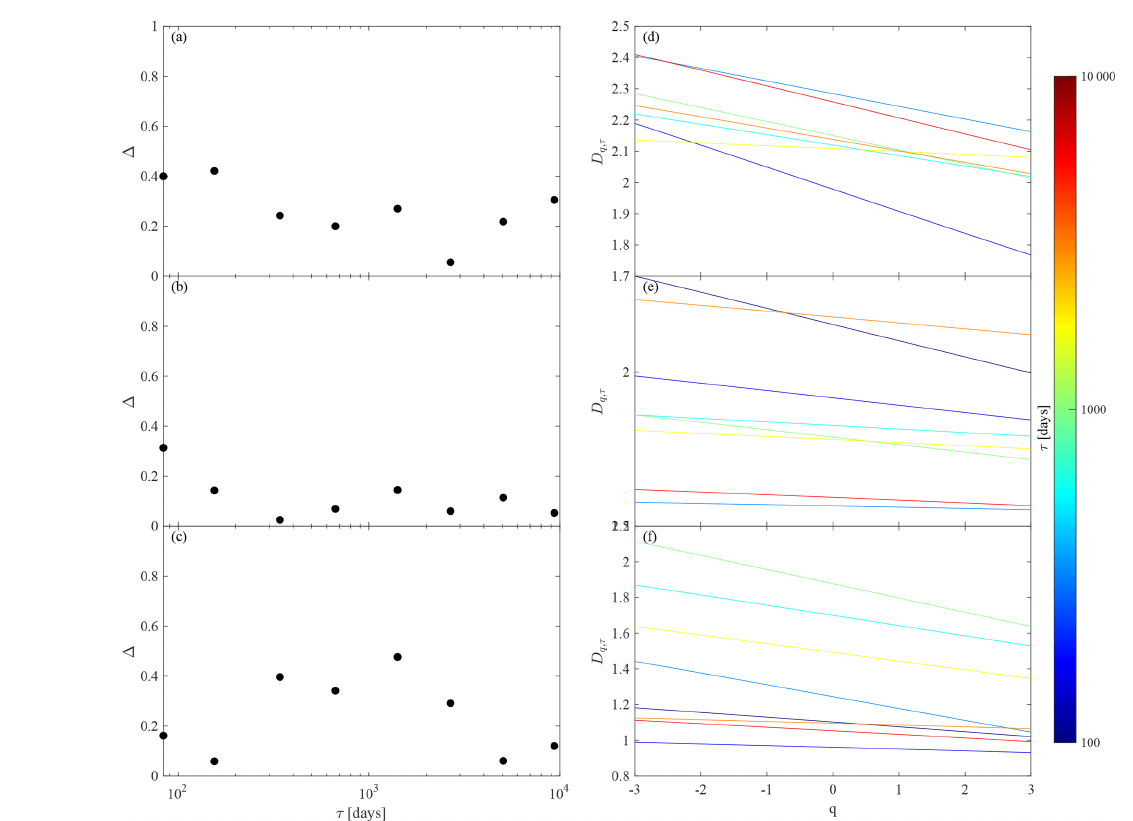
Figure 13. (a–c) Multifractal width (cid:49) and (d–f) D q,τ spectra at different timescales τ j for reconstructions of MIMFs as in Eq. (12) ( D q,τ ) for (a, d) the North Atlantic, (b, e) the North Pacific, and (c, f) the tropical Pacific,